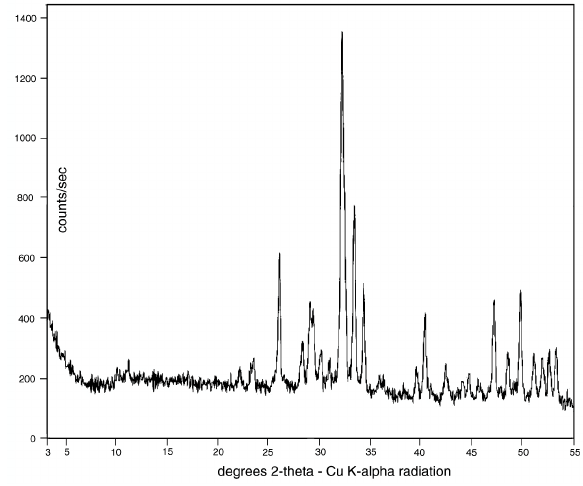
Figure 9. X-Ray diffraction ( XRD) pattern. All peaks are from an apatite group